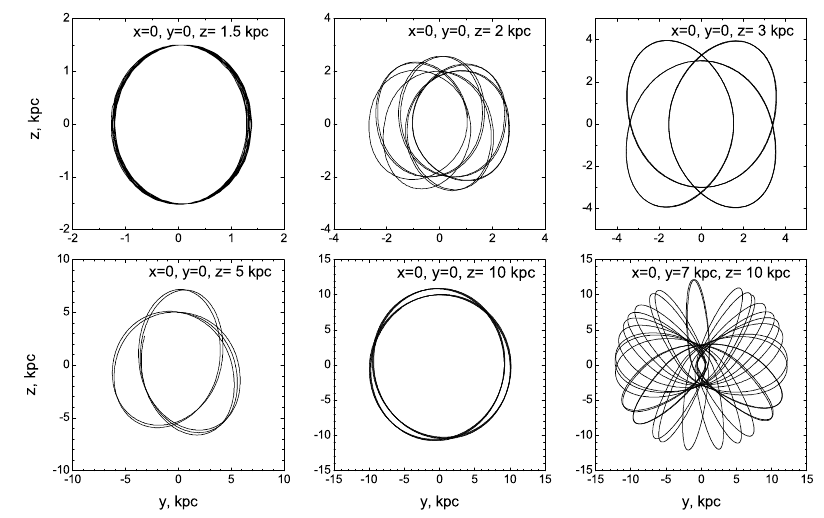
Fig. 1. Examples of orbits in the ( Y; Z ) plane.